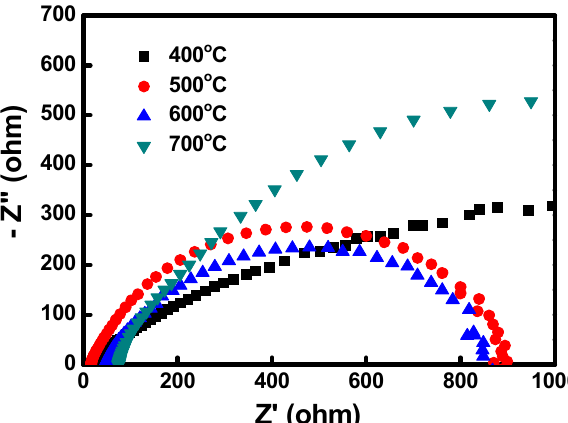
Figure 10. The EIS Nyquist plots of DSSCs using various Cu 2 O counter electrodes.